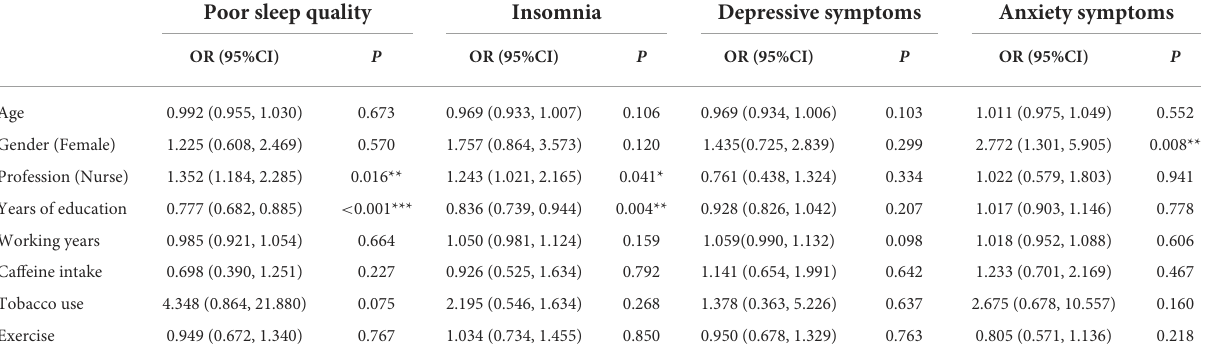
TABLE 2 Logistic regression analyses for associated factors of psychological and sleep